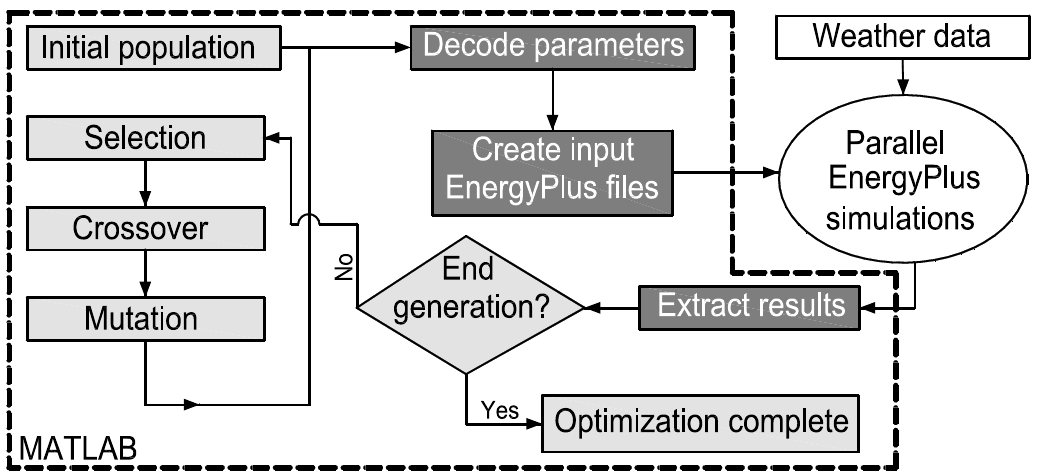
Figure 1. Flowchart diagram for the developed simulation/optimization tool.